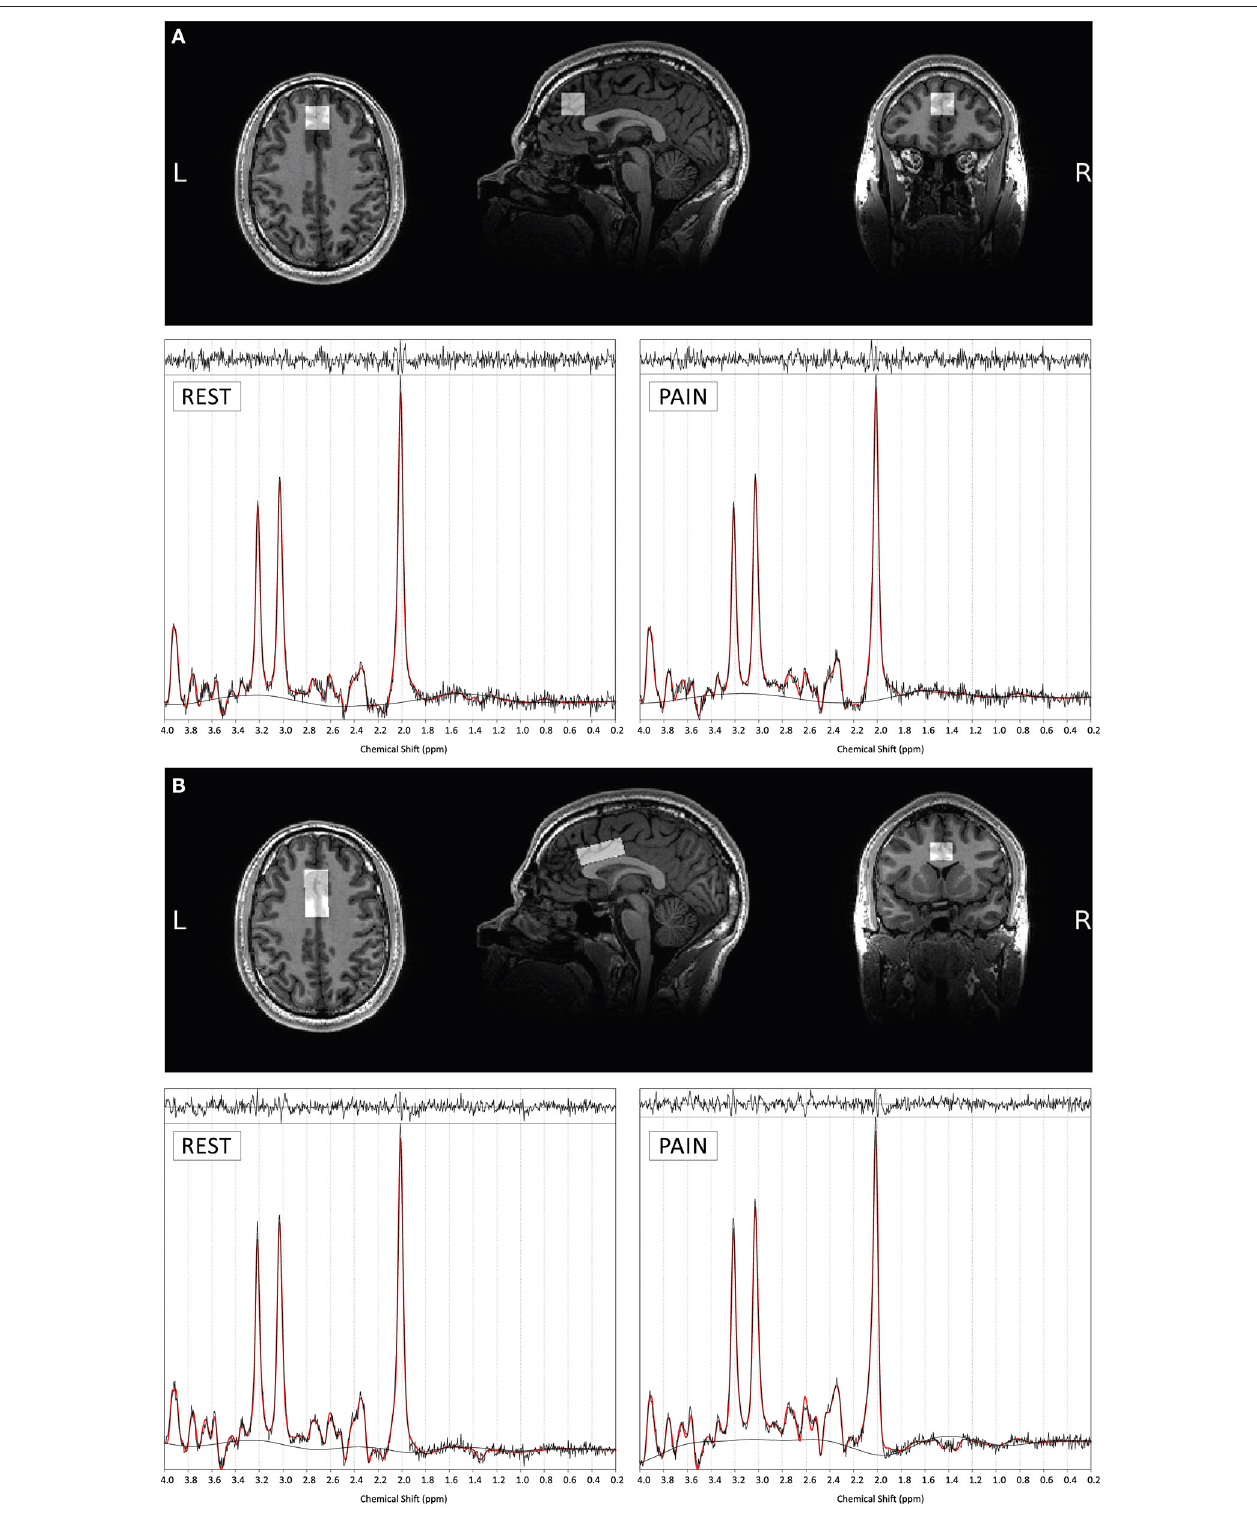
FIGURE 3 | Example voxel positioning and associated 1 H-fMRS spectra (for a single subject) for ROI 1- ACC (A) and ROI 2- dACC (B) . The screen shots of the orthogonal views are taken through the center of each plane of each of the voxels. Example TARQUIN output is shown for REST and PAIN conditions with output of the fit (red) overlaid on the acquired spectrum (black). The estimated baseline is displayed under each spectrum in black.